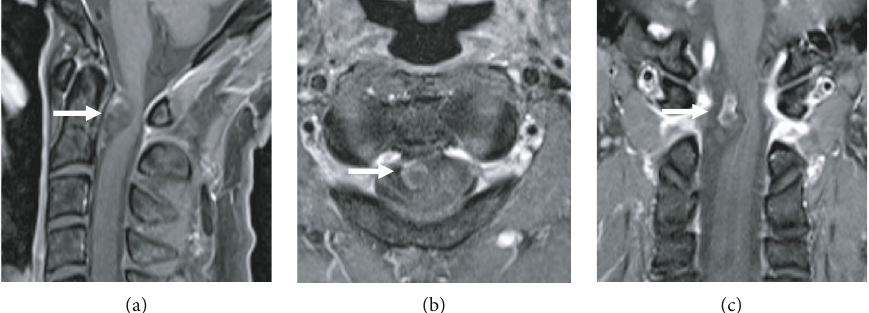
Figure 3: Contrast-enhanced magnetic resonance imaging of the cervical spine. Because a cyst was partially enhancing, a tumor lesion was not identi fi able ((a) sagittal, (b) horizontal, (c) coronal,